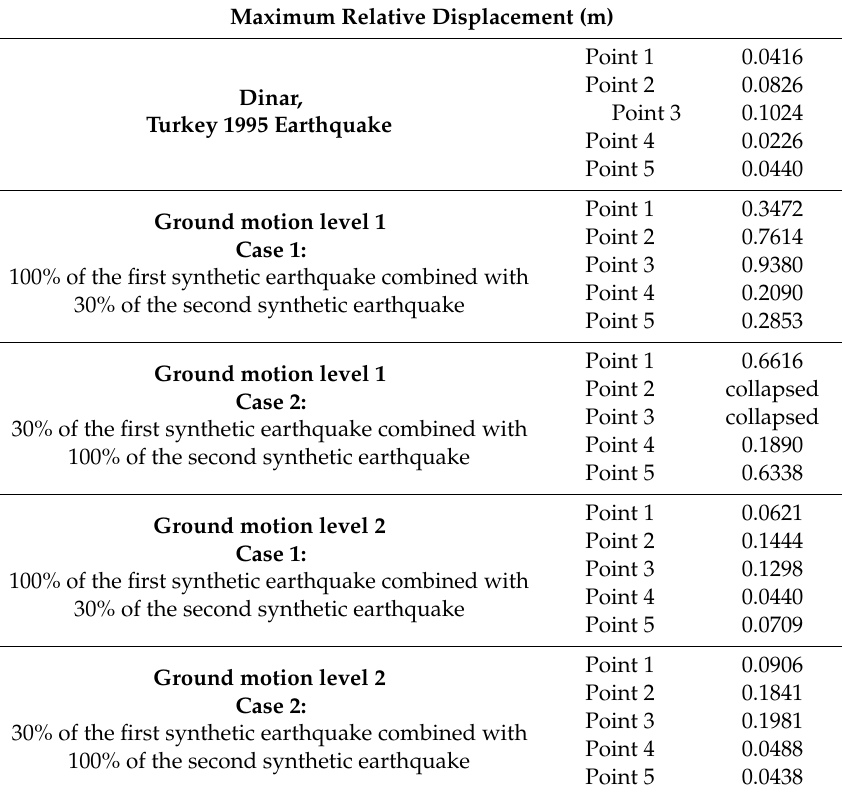
Table 3. Maximum displacement relative to